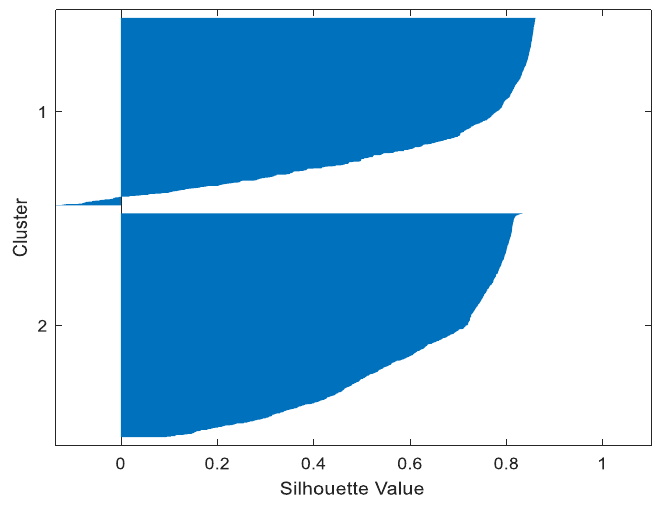
Figure 21. Cloud FP-Conv-CM.